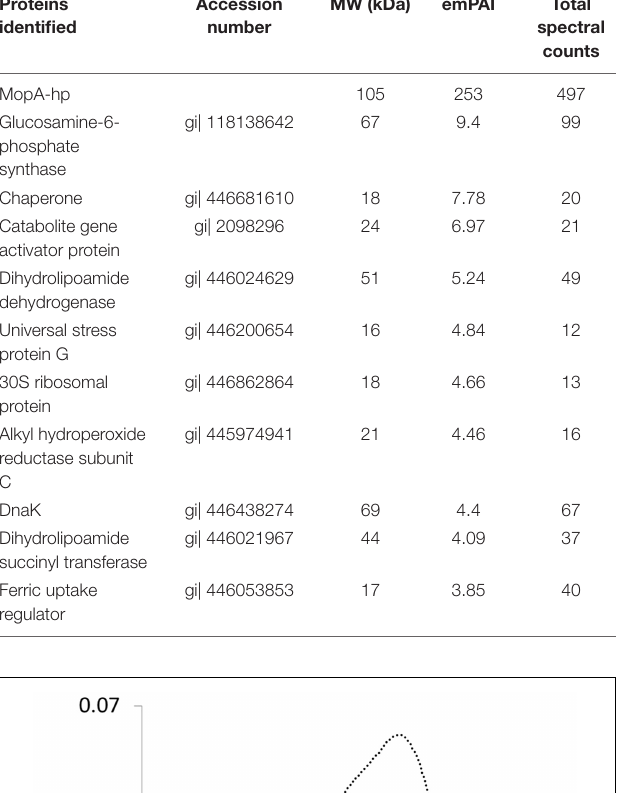
TABLE 3 | Proteins identified in the NAC purified MopA-hp preparation by trypsin digestion and LC-MS/MS. Proteins identified